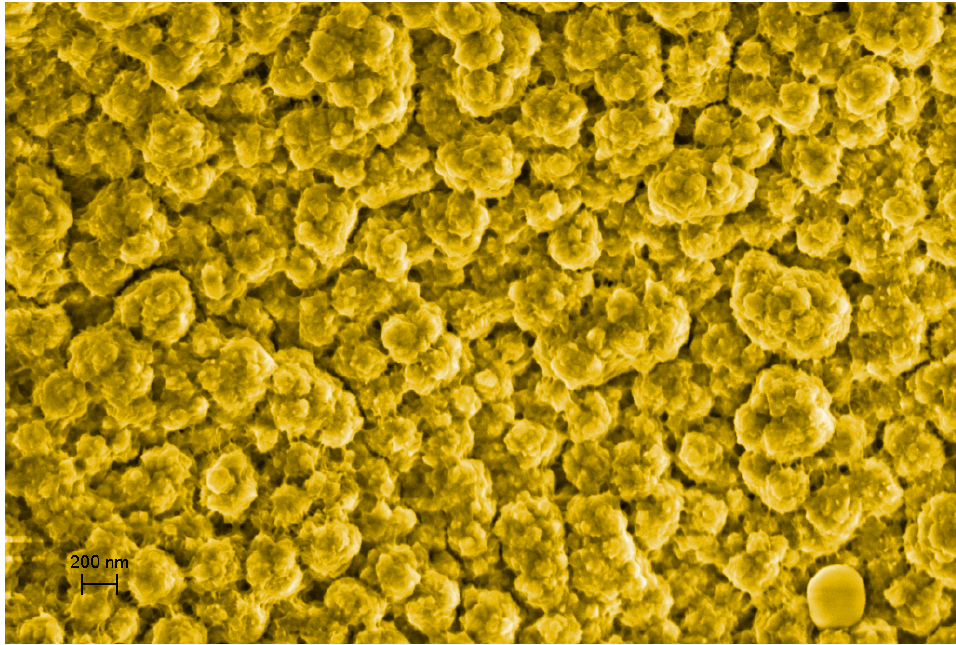
Figure 3. Artificially colored SEM image of the metallopolymer on the platinum electrode. The scale bar is 200 nm.